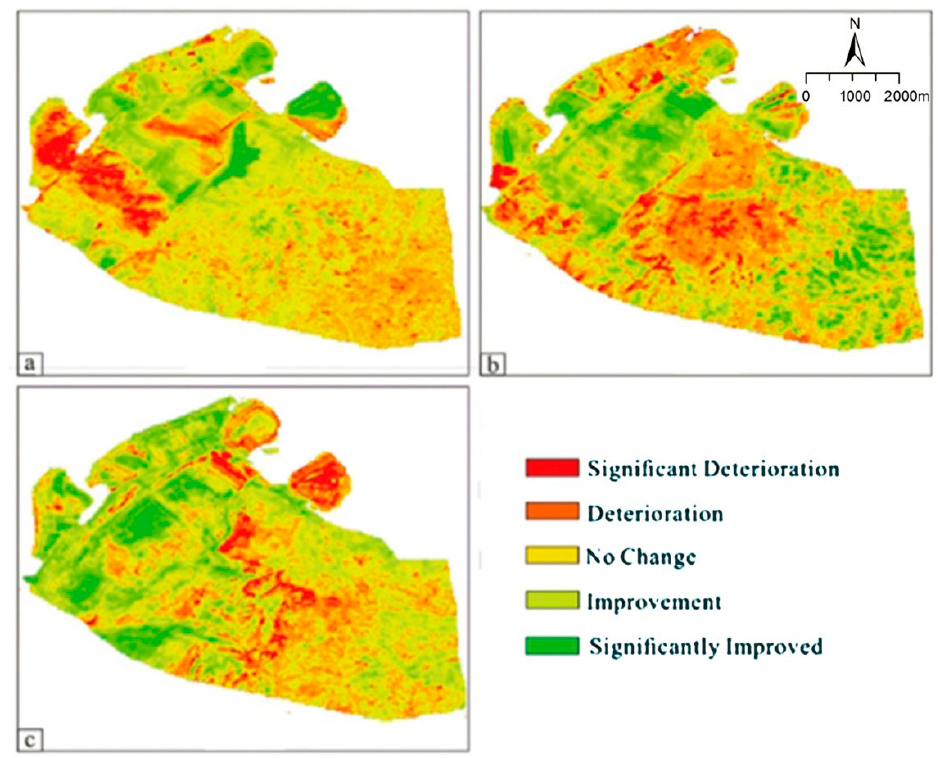
Figure 12. Characteristic map of eco–environmental quality evolution in different periods in mining area . ( a ) 2006–2011; ( b ) 2011–2016; ( c ) 2016–2021. area. ( a ) 2006–2011; ( b ) 2011–2016; ( c )